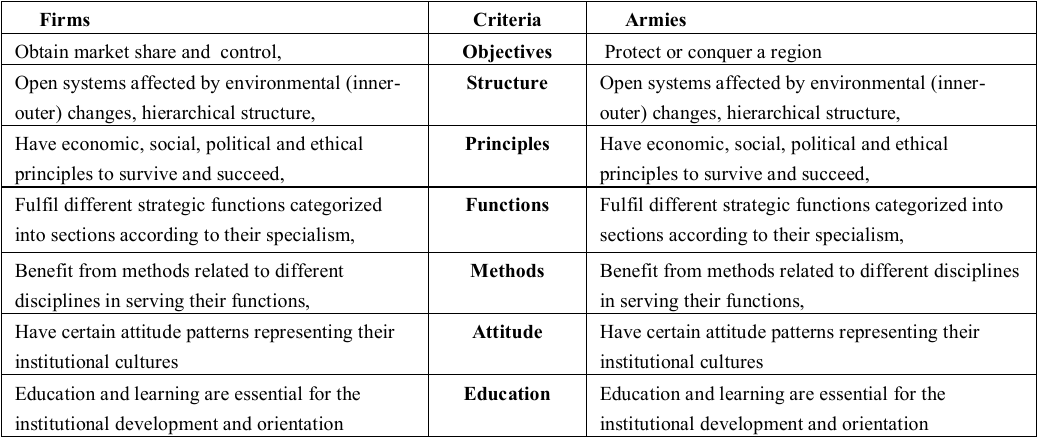
Table 1: The Comparison of the Firms and